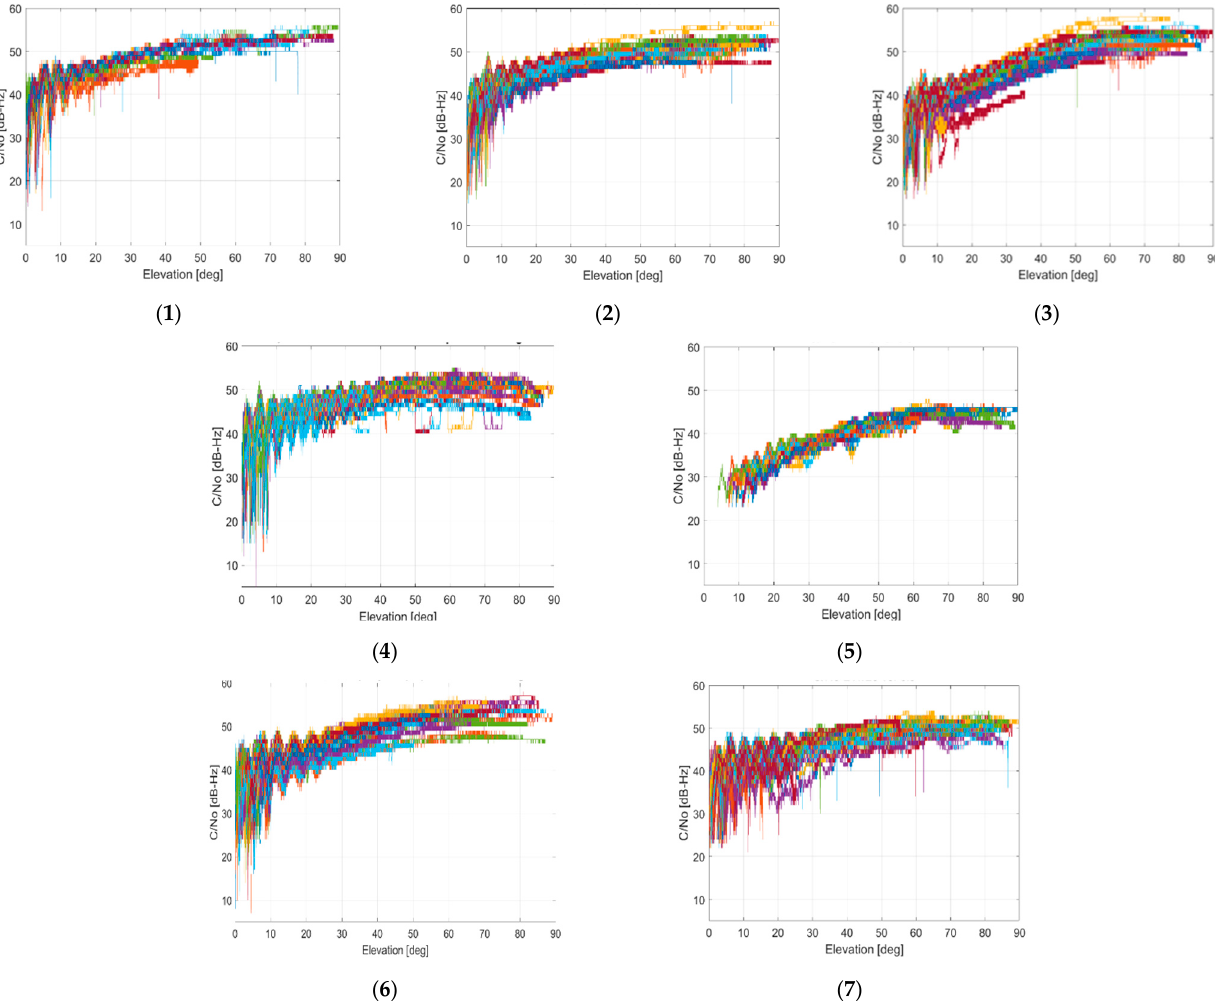
Figure A11. C/N0 at L1/E1 for the antennas measured at DLR; from left to right, from top to bottom: ( 1 ) Leica AR25 R4; ( 2 ) Novatel GNSS-750; ( 3 ) Javad RingAnt-DM; ( 4 ) Space Engineering GalExpAnt; ( 5 ) DLR internal design; ( 6 ) Navxperience Nav3G+C; ( 7 ) Tallysman VSE6028 VeroStar. Different colors indicate different PRNs.